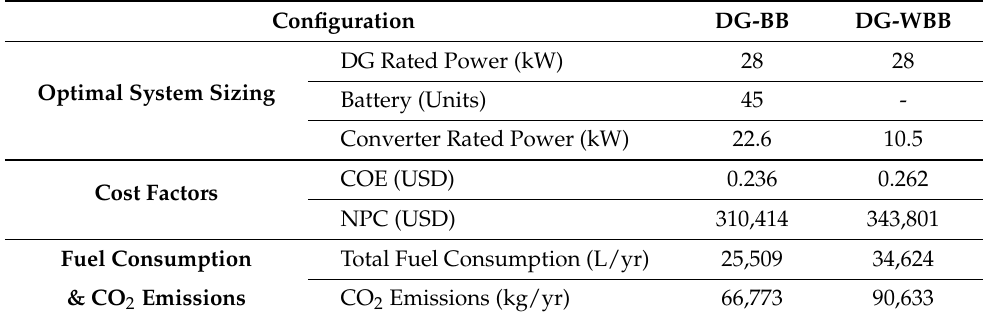
Table 19. Simulation Results for Wafra—DG-BB and DG-WBB Configurations.